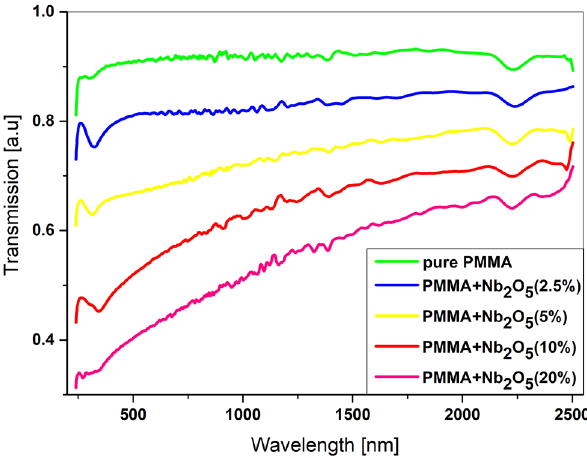
Figure 3. Transmission of pure PMMA and PMMA/Nb 2 O 5 films.